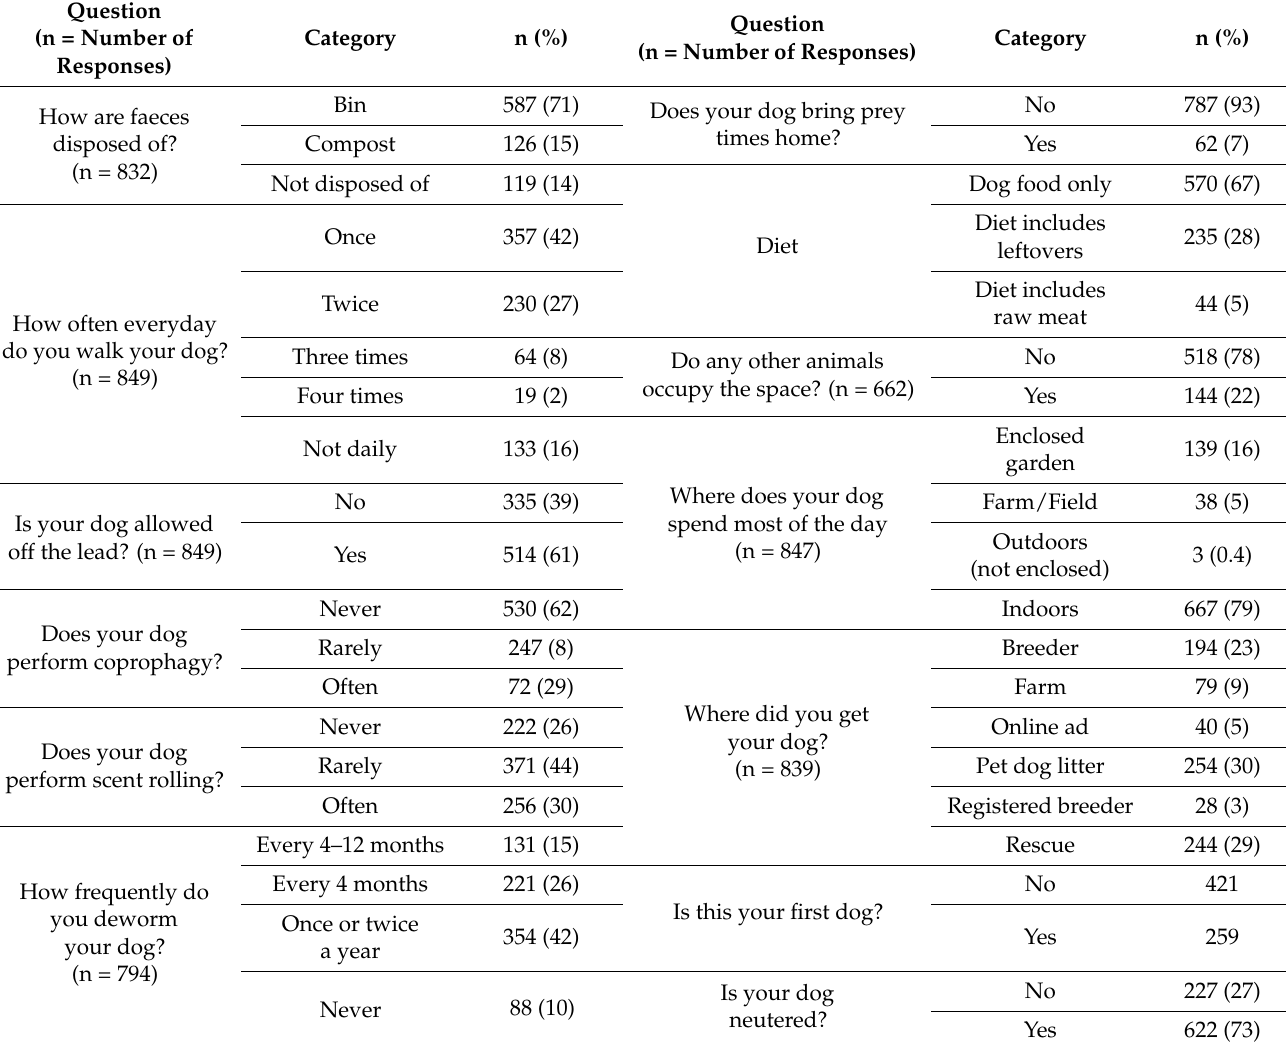
Table 2. Responses of dog owners to questions relating to individual dogs.